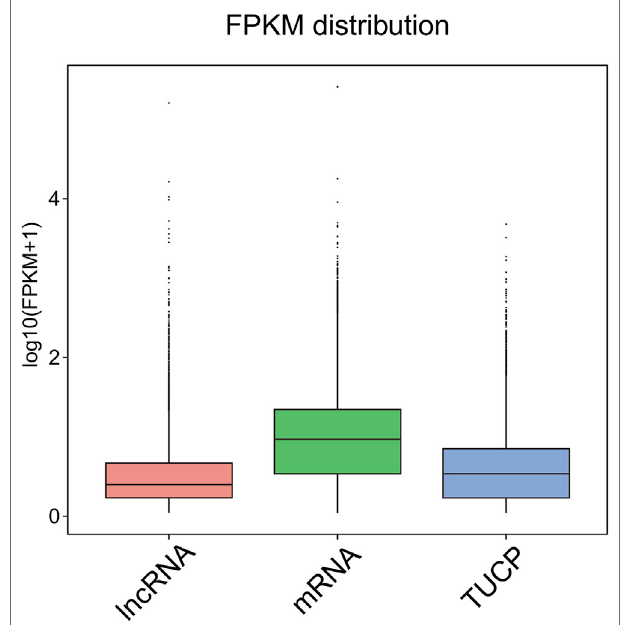
FIGURE 2 | Box plots showing the expression levels of different types of transcripts. The horizontal coordinates indicate the different types of transcripts and the vertical coordinates are log10 (FPKM+1); there are box plots of each region for fi ve statistics (maximum, upper quartile, median, lower quartile, and